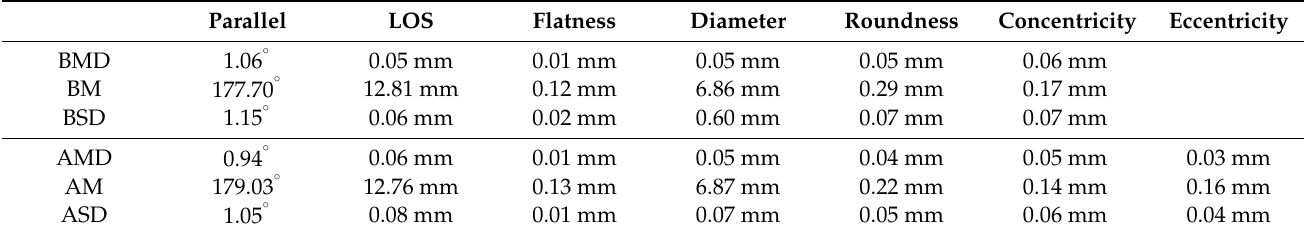
Table 3. Normal nut detection.